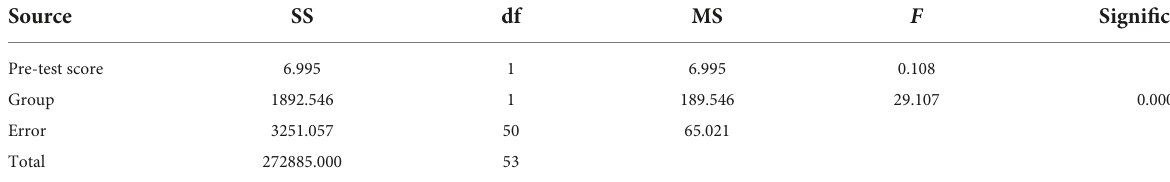
TABLE 5 The standard deviation of pretest results for learning attitude.